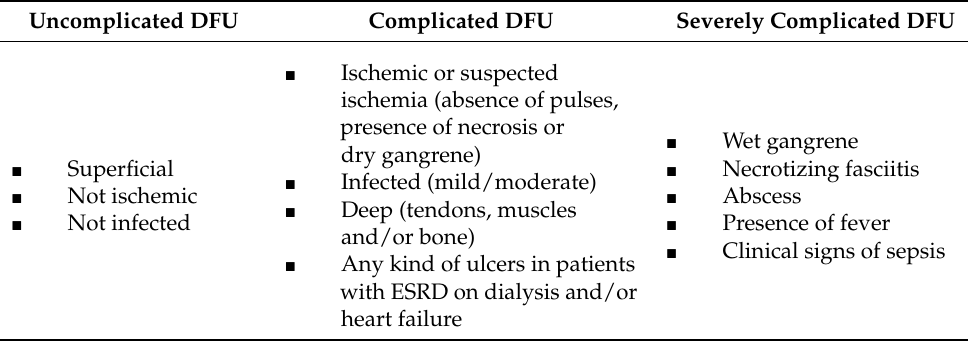
Table 1. Definition of three levels of DFU severity, according to the fast-track model. DFU: diabetic foot ulcer; ESRD: end-stage renal